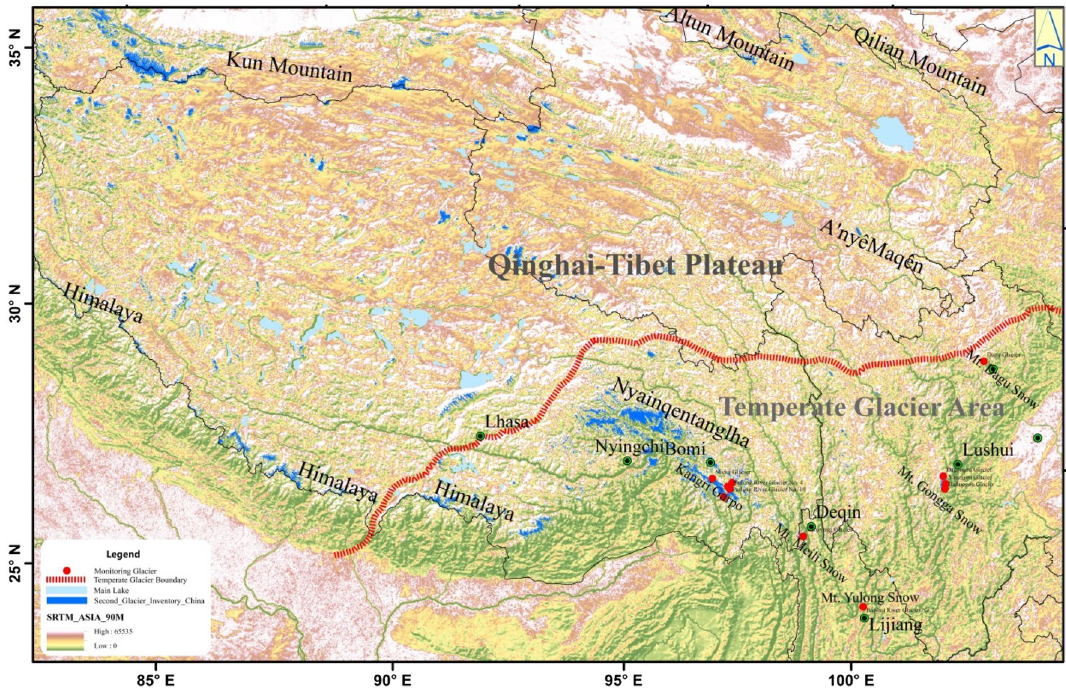
Figure 1. The range of China’s temperate glaciers and the prevailing airflow affecting the region. The final map was created by ArcMap version 10.2 (http://deskt op.arcgi s.com/en/arcma